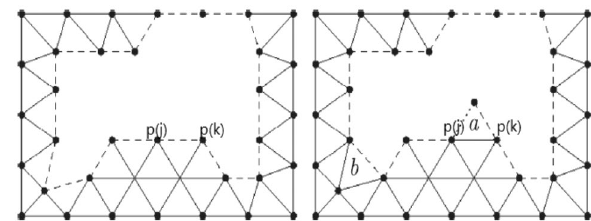
Figure 1. Schematic diagram of mesh generation by AFM.